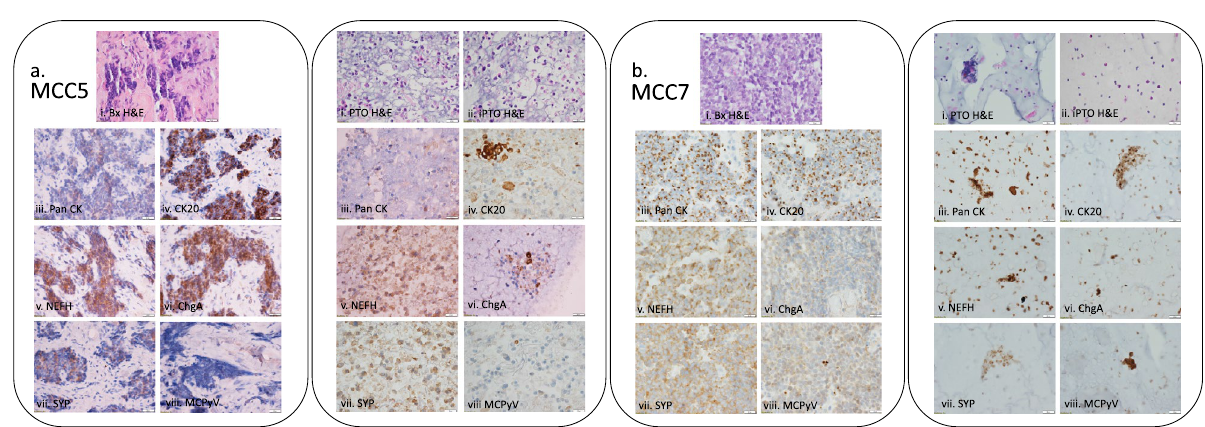
Figure 2. Immunohistochemistry of matched patient tissue (Bx) and Merkel cell carcinoma PTO set ( a ) MCC5 and ( b ) MCC7. Comparison of tissue and PTOs shows high concordance of identification markers including (viii) Merkel cell polyomavirus (MCPyV). Additionally, sets MCC5 ( a ) and MCC7 ( b ) demonstrated variable expression of markers related to disease identification and potential outcomes, including MCPyV. All